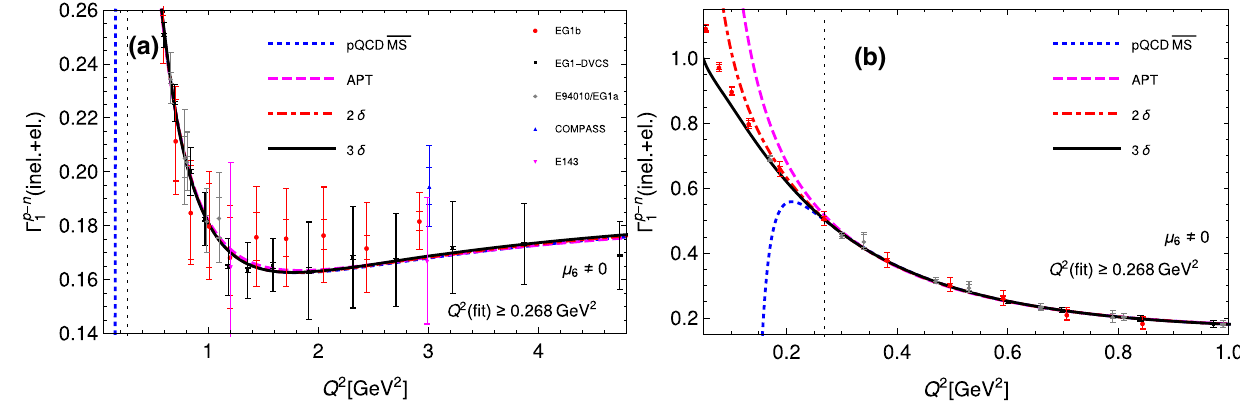
Fig. 4 As Fig. 3, but shifted upwards by the parametrized elastic contribution (11) [cf. also Eqs.